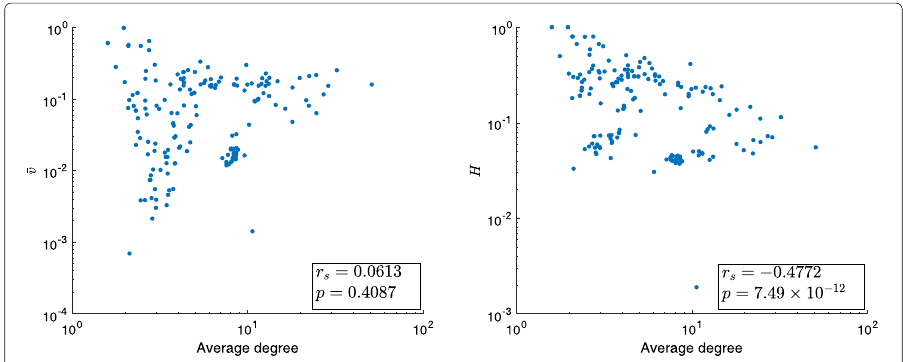
Fig. 4 Normalised degree variance, left, and heterogeneity, right, of 184 real-world networks plotted against their average